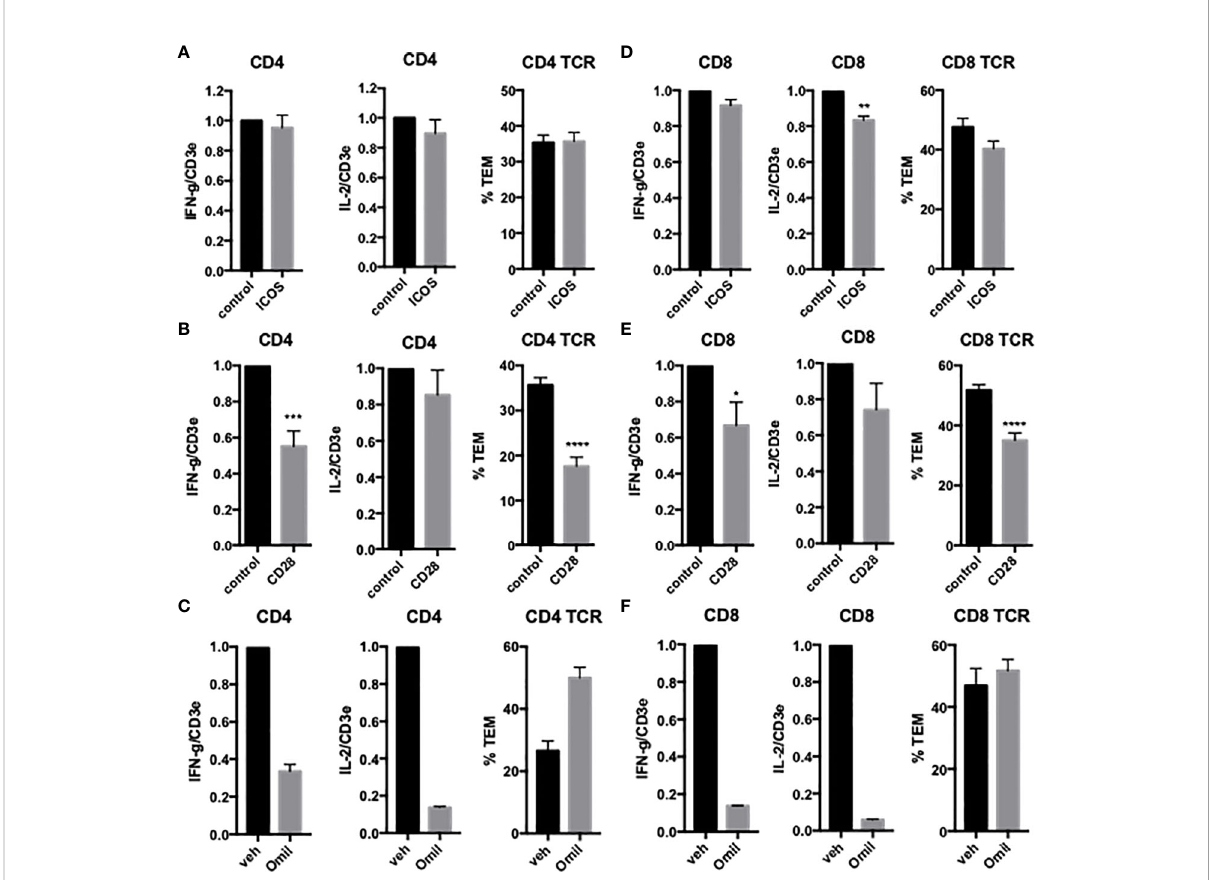
FIGURE 3 Effects of T cell CD28 and ICOS on cytokine expression and TCR-TEM of CD4 and CD8 T EM . CD4 (A, B) and CD8 (D, E) T EM treated with ICOS blocking Ab (A, D) or CD28 blocking Ab (B, E) assayed as in Figure 1. Cytokine expression and TCR-TEM of CD4 (C) and CD8 (F) T EM cells treated with Omilpalisib (Omil) assayed as in Figure 1. *p<0.05; **p<0.01; ***p<0.001;